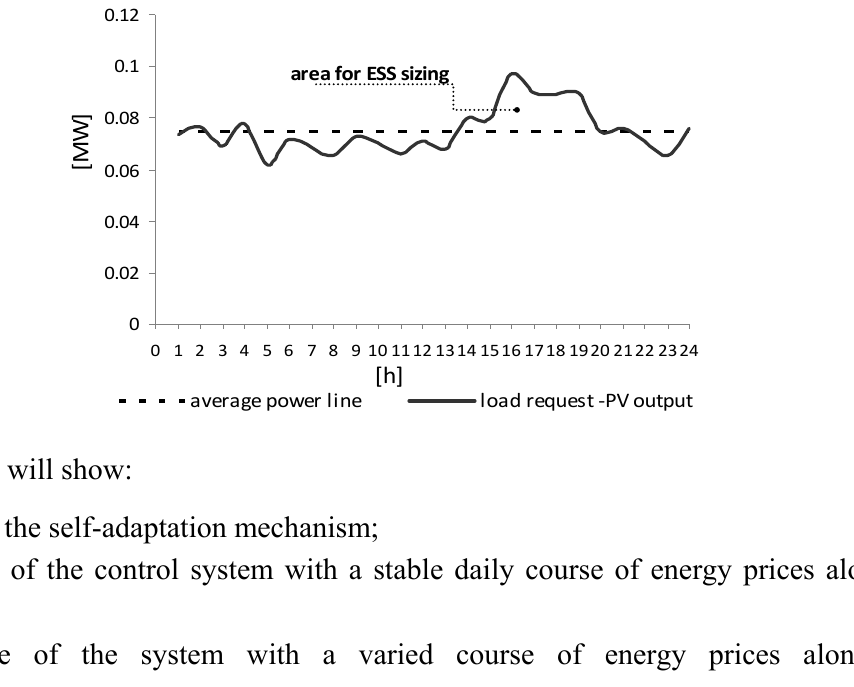
Figure 6. For a typical daily behaviour, the average power required by the summation of the residential load request and the PV generator output along 24 h has been taken. Then the larger area below the average power line has been assumed to be the size of the ESS, with a security factor of 10%. Figure 6. Photovoltaic production and load request in 24 h and sizing of